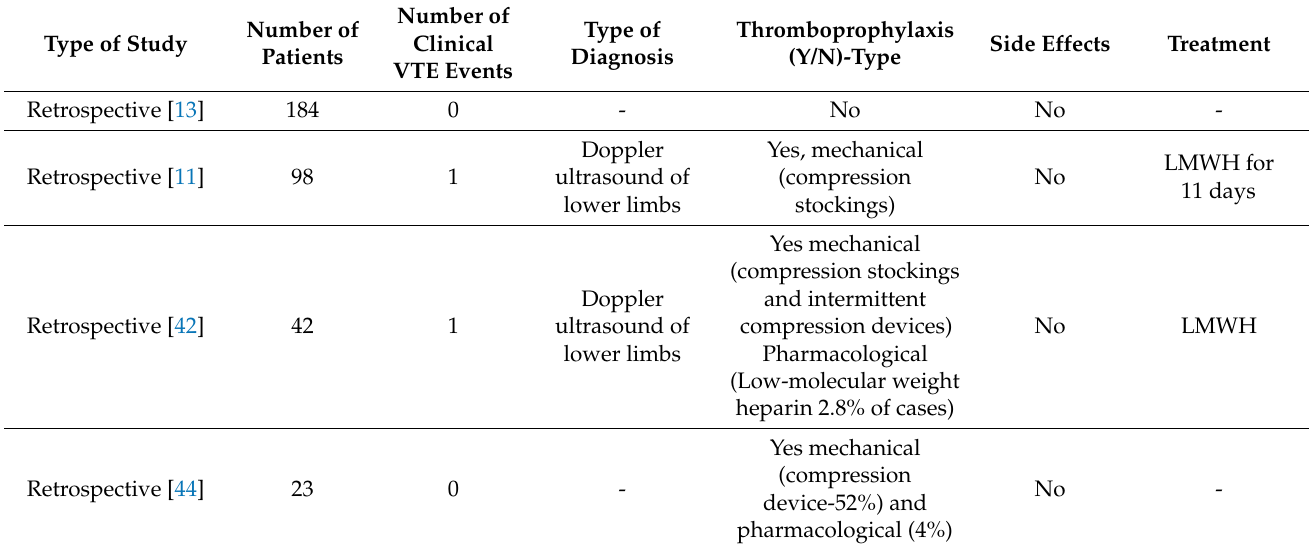
Table 3. Summary of the studies reporting episodes of clinical deep vein